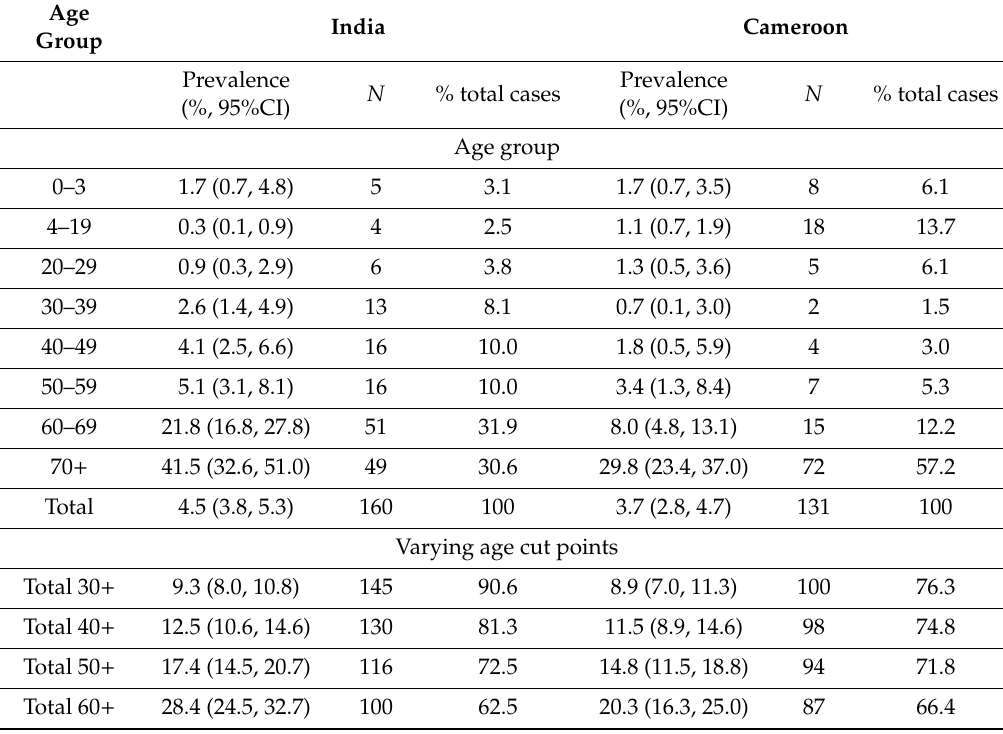
Table 1. Prevalence of and proportion of total hearing loss cases ( ≥ 41 dB adults; ≥ 31 dB children), by age group and by varying age cut points (30 + ; 40 + ; 50 + ) in India and Cameroon.